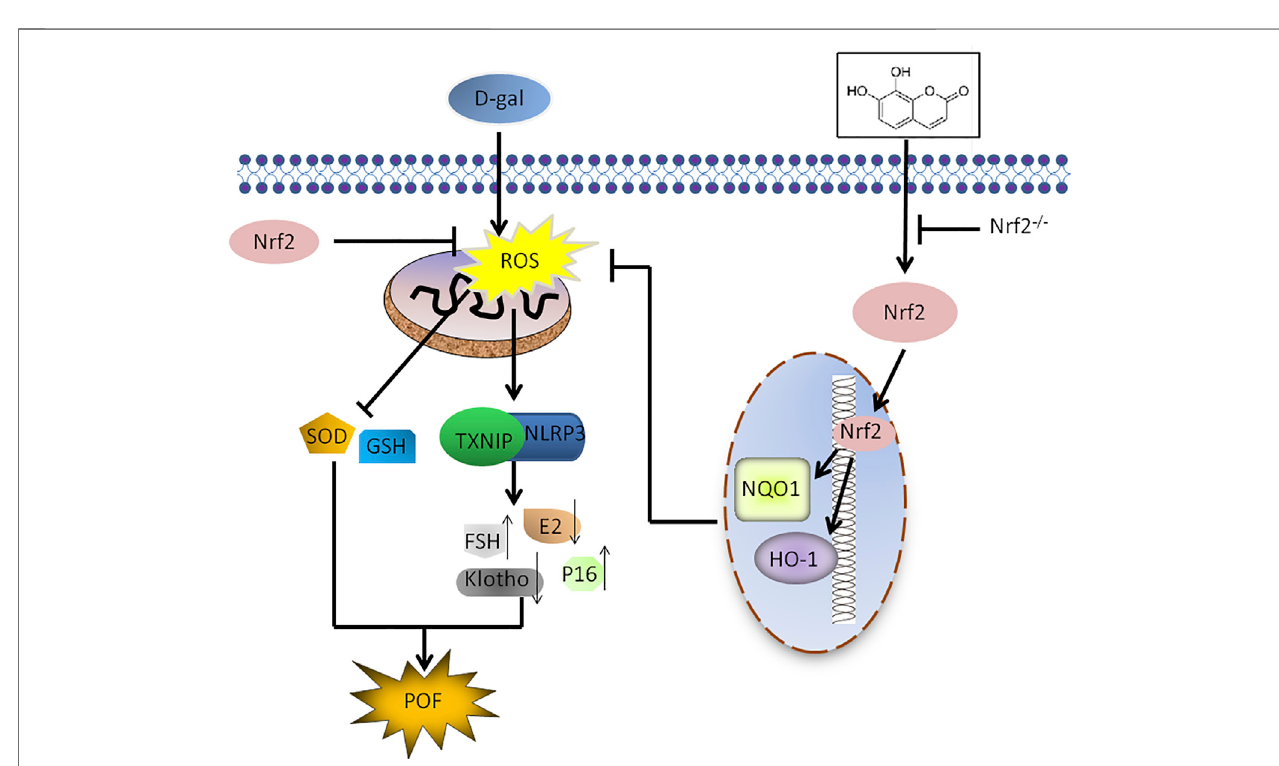
FIGURE9| SchemesummarizingtheprotectiveeffectsofNrf2activationonD-gal-inducedPOF via inhibitingTXNIP/NLRP3in fl ammasomeactivation.UnderD-gal condition, Nrf2downregulationincreasestheaccumulation ofROS,and then increase TXNIP/NLRP3, p16and FSH and decrease klotho, SOD,E2and GSH,